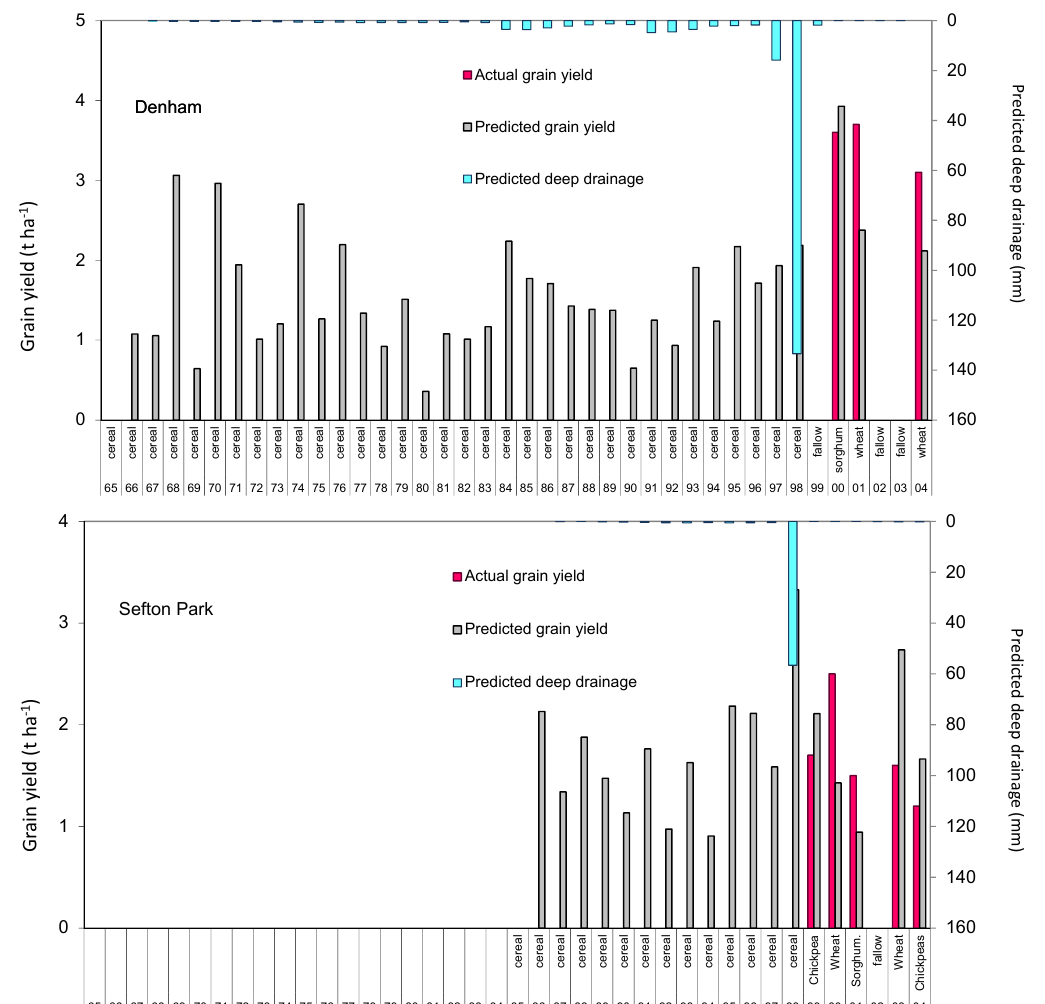
Fig. 10. Actual crop yields (pink), APSIM predicted crop yields (grey) and deep drainage (blue), compared to paddock records and grain yields for (a) Denham since 1966 and (b) Sefton Park since 1986. One significant deep drainage event is evident in